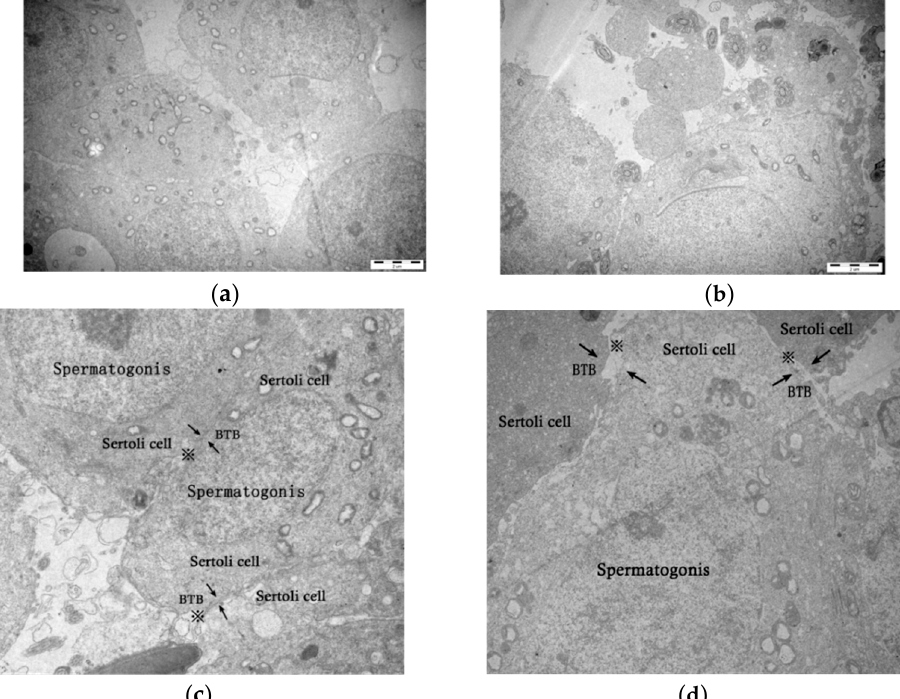
Figure 2. Transmission electron microscope (TEM) micrographs of Kunming (KM) mice testes (6200×). ( a , c ) Images belong to the testes of the control mice, ( b , d ) are the testes of the acutely infected mice. ( a ) The cell boundaries and the spermatogonia were clearly visible. ( b ) The structure of the testis was destroyed, the cells were incomplete, and the boundary between spermatogonia and Sertoli cells was not obvious. ( c ) The tight junctions ( ※ ) between the Sertoli cells were seamless and the blood–testis barrier (BTB) structure was complete. ( d ) The tight junctions’ intercellular spaces ( ※ ) between Sertoli cells increase, and the BTB structure was incomplete.